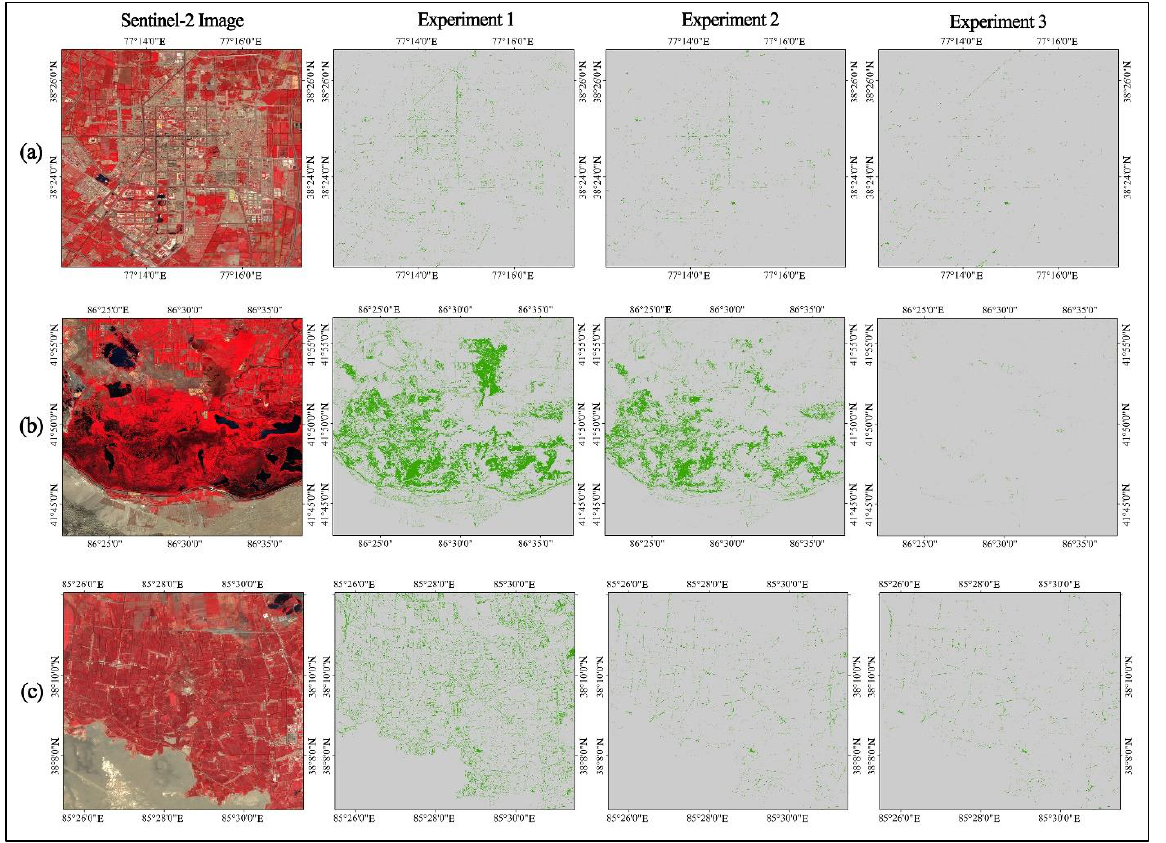
Figure 11. Detailed results for experiment one, experiment two, and experiment three for regions with fewer P. euphratica trees. ( a ) Results for the urban area; ( b ) results for vegetation in wetlands; ( c ) results for